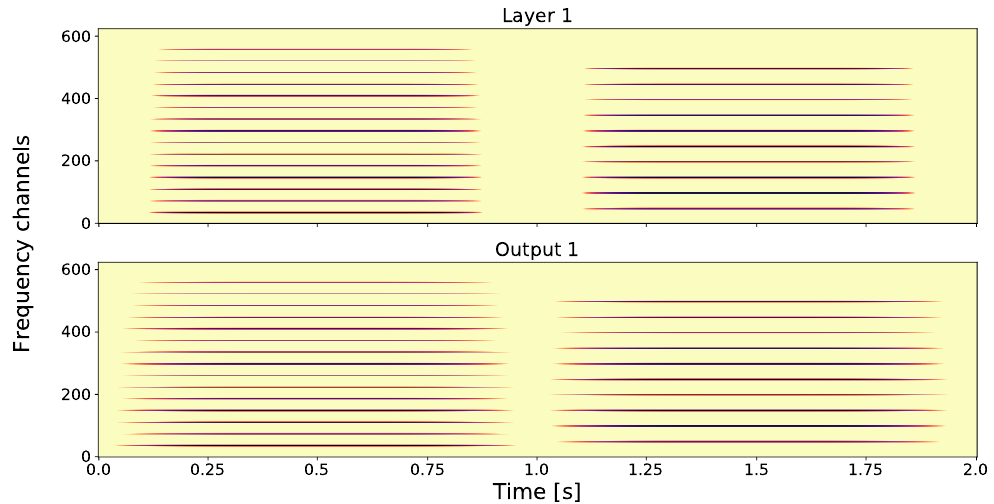
Figure 3. First layer (i.e., GT) and Output 1 of two tones with different fundamental